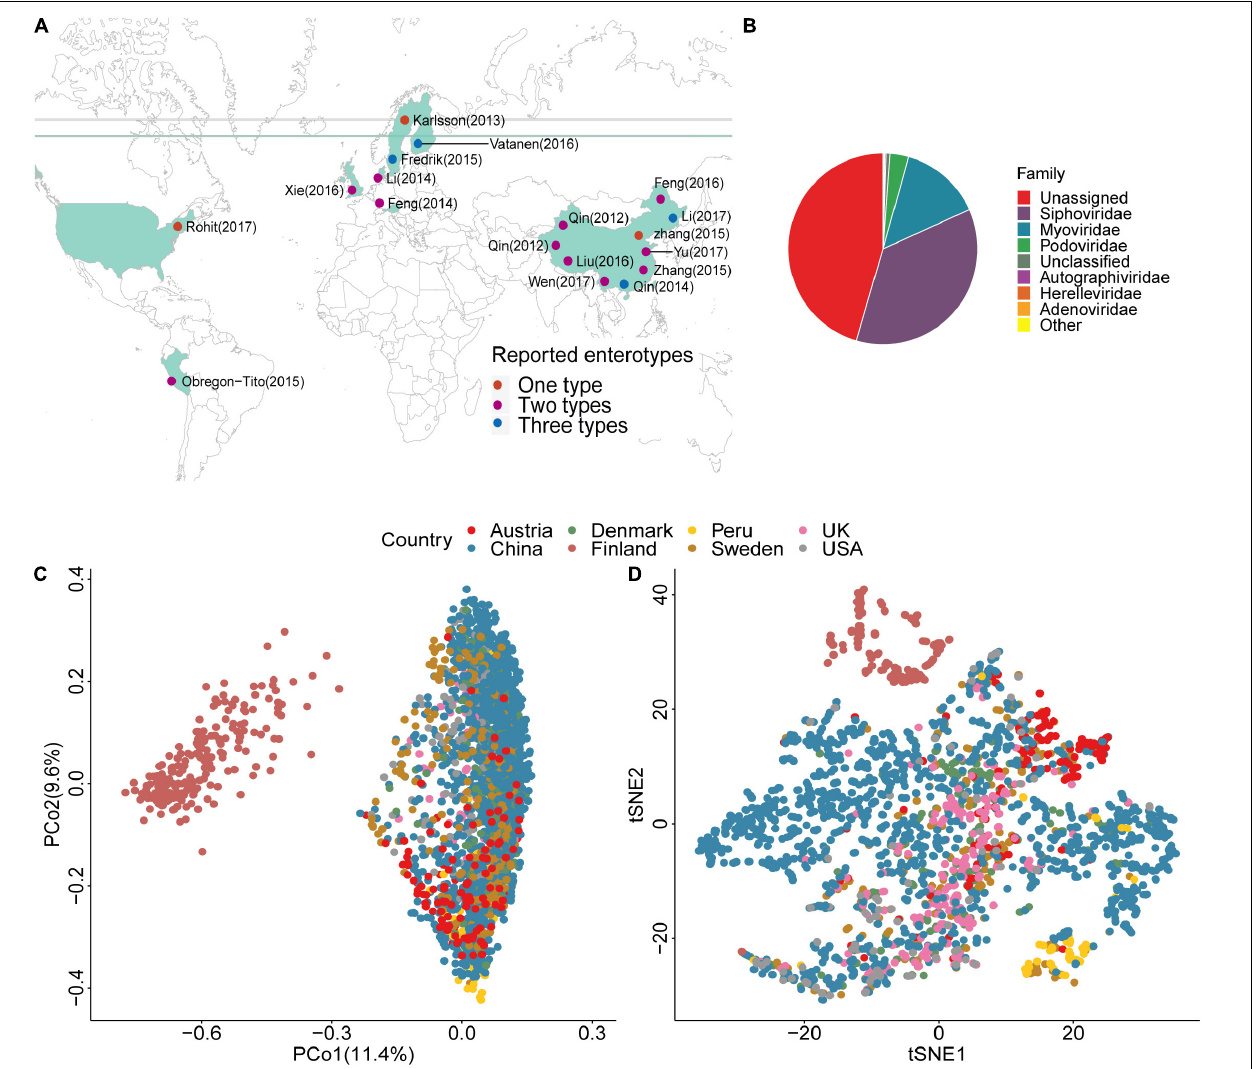
FIGURE 1 | Location, taxonomic assignment, and abundance of the 2,690 samples. (A) Geographic locations of the 18 projects, with classification by the number of enterotypes. (B) Pie chart shows viral taxonomic assignment at the family level by protein alignment. (C) Principal Coordinates Analysis (PCoA) plot based on the Bray–Curtis distance and the relative abundance of viruses. (D) t-Distributed Stochastic Neighbor Embedding (tSNE) plot based on the relative abundance of viruses.